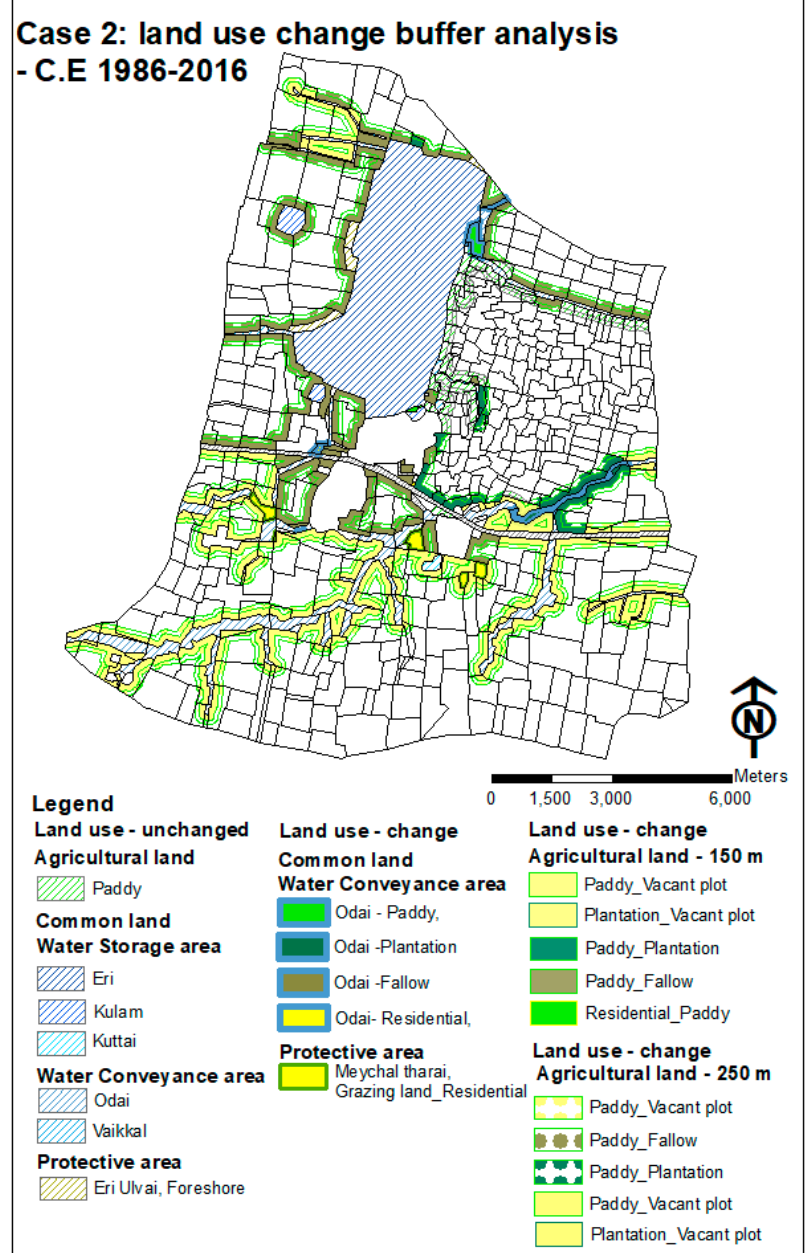
Figure A5. Output of buffer analysis—case 2.